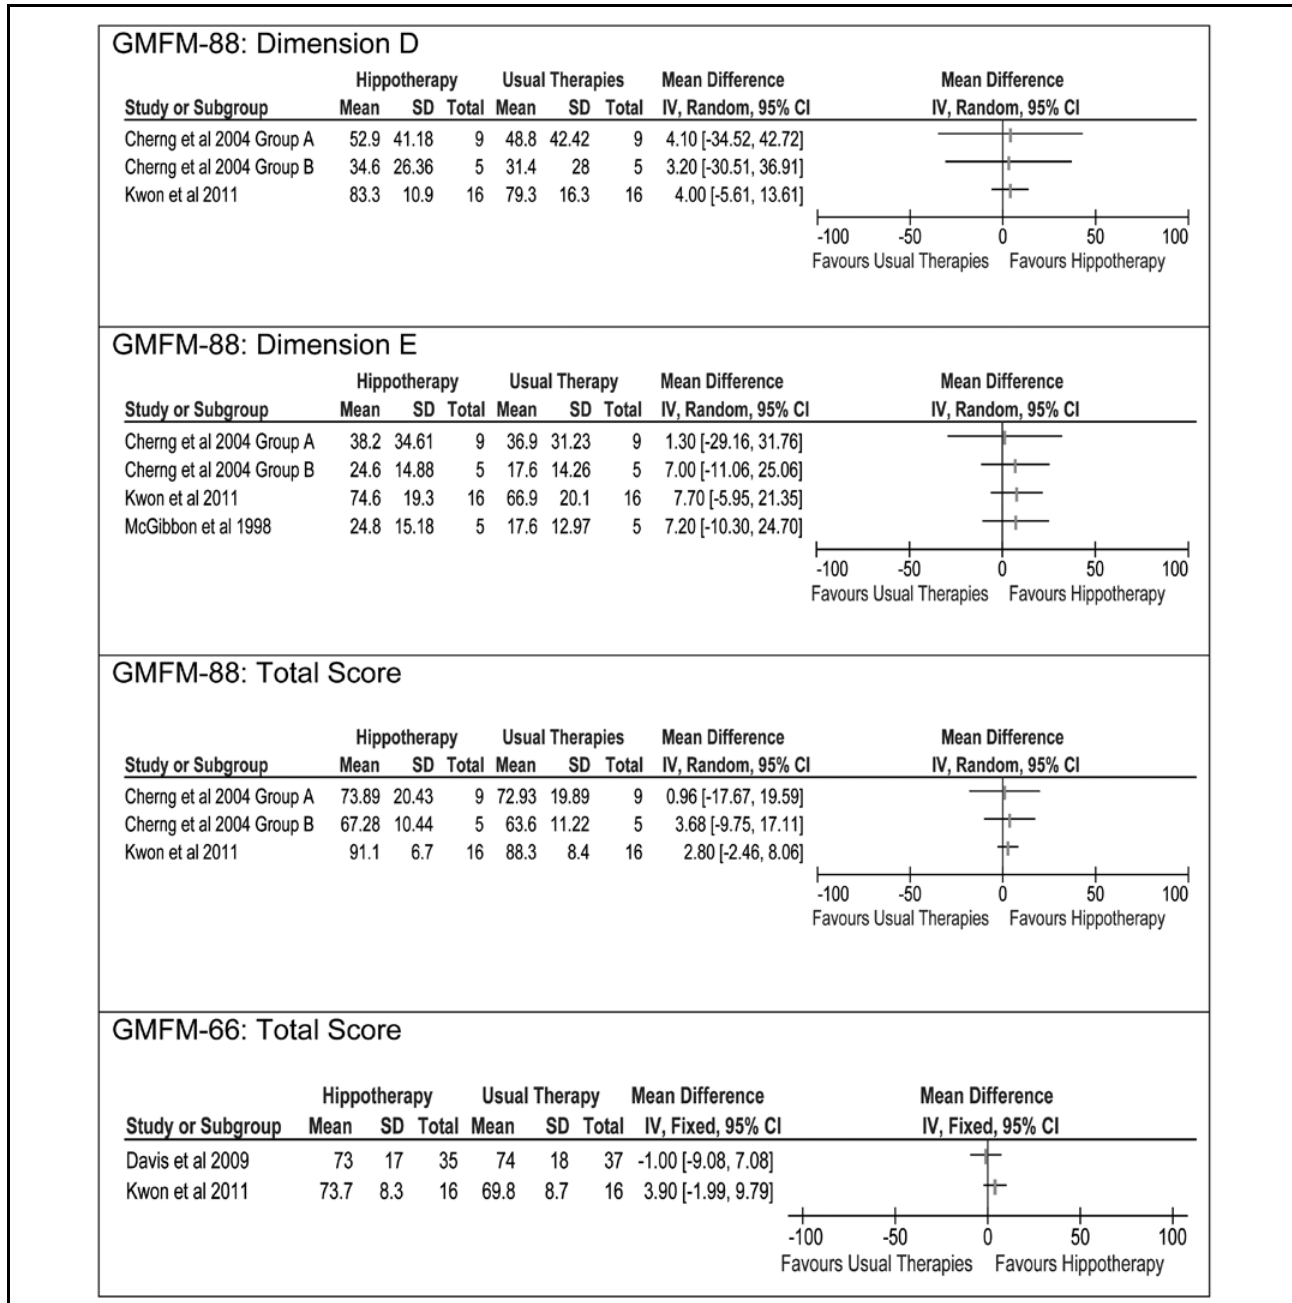
Figure 2: Forest